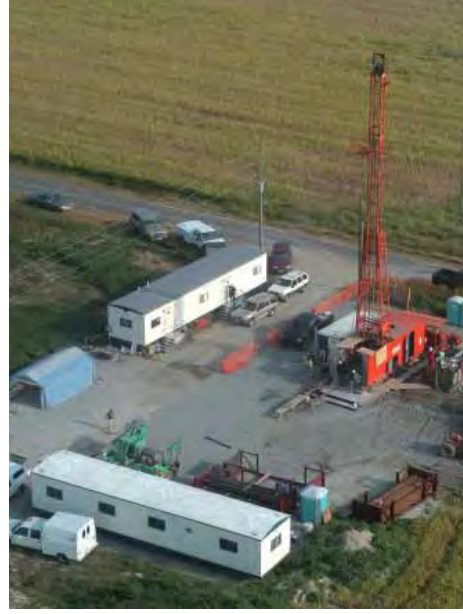
Figure 3. Low-altitude aerial photograph of Eyreville drilling